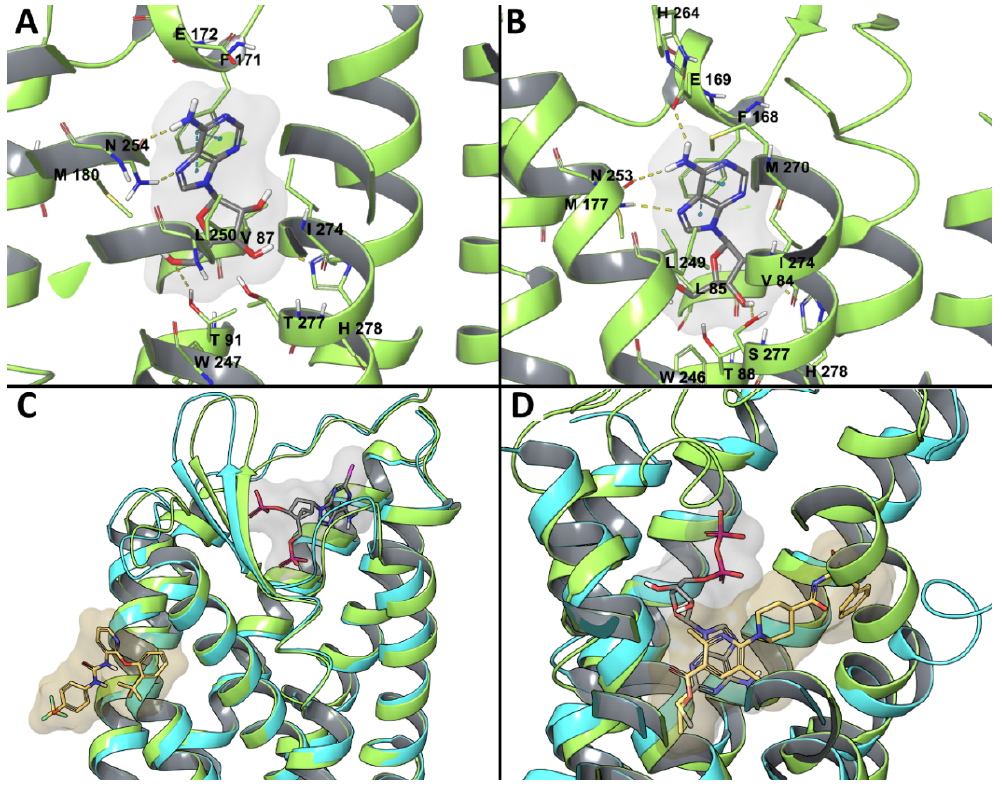
Figure 2. ( A ) cryogenic electron microscopy (cryo-EM) structure of the active-state A 1 AR (light green) bound to adenosine (gray) [39]. ( B ) X-ray structure of the intermediate-state A 2A AR (light green) bound to adenosine (gray) [33]. ( C ) Superposition of the X-ray structures of MRS2500-bound and BPTU-bound P2Y 1 Rs [40]. MRS2500 is depicted by grays sticks and the corresponding receptor in light green, while BPTU is reported in orange sticks and the relative receptor in cyan. ( D ) Superposition of the X-ray structures of 2MeSADP-bound and AZD1283-bound P2Y 12 Rs [41,42]. 2MeSADP is depicted by gray sticks and the P2Y 12 R in light green, while AZD1283 is reported in orange sticks and the receptor in cyan.